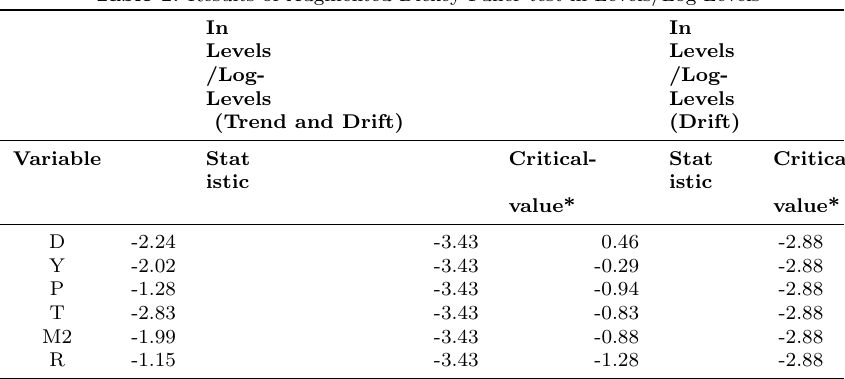
In Levels /Log- Levels